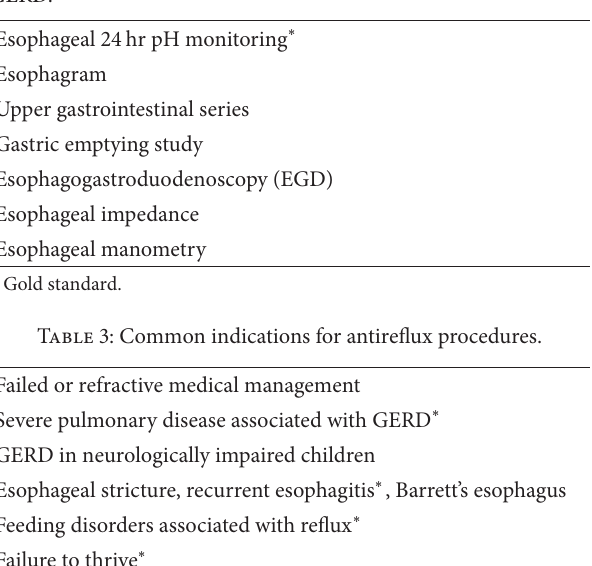
Table 1: Common symptoms of infant and adolescent patients presenting with GERD [8].